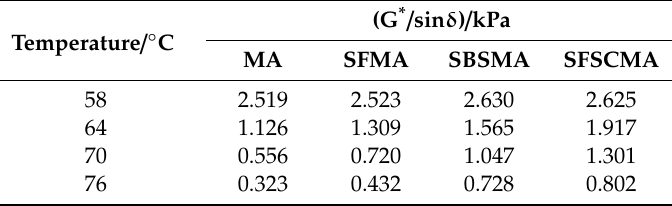
Table 9. Factors (G * / sin δ ) of four kinds of asphalt.